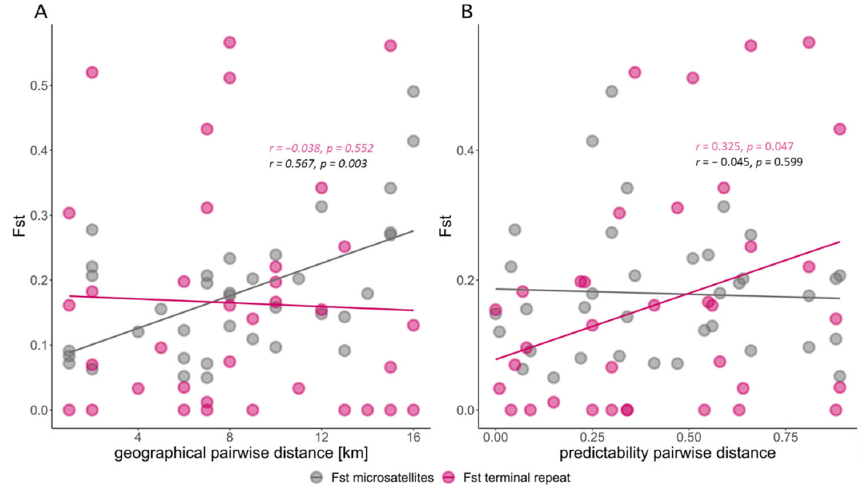
Figure 4. Relationship between F ST for neutral markers (in grey) and terminal repeats of mmr-b (in magenta) and geographical distance ( A ) and pond predictability ( B ), respectively. Person’s correlation coefficients are shown ( p values based on a Mantel test with 100,000 permutations). The phenotypic result of the mmr ‐ b gene (i.e., length of the protein which depends on